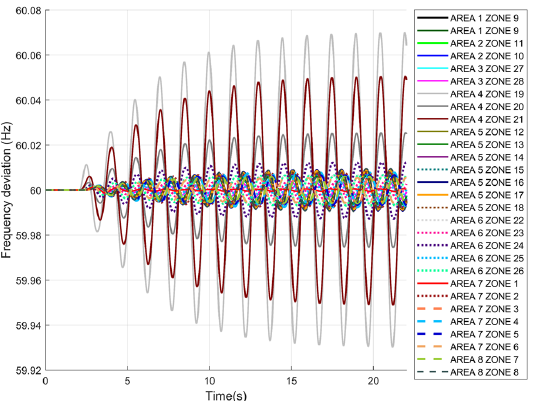
Figure 6. Frequency response at different zones when the 0.67 Hz forced oscillation source is located at Area 4 Zone 19.